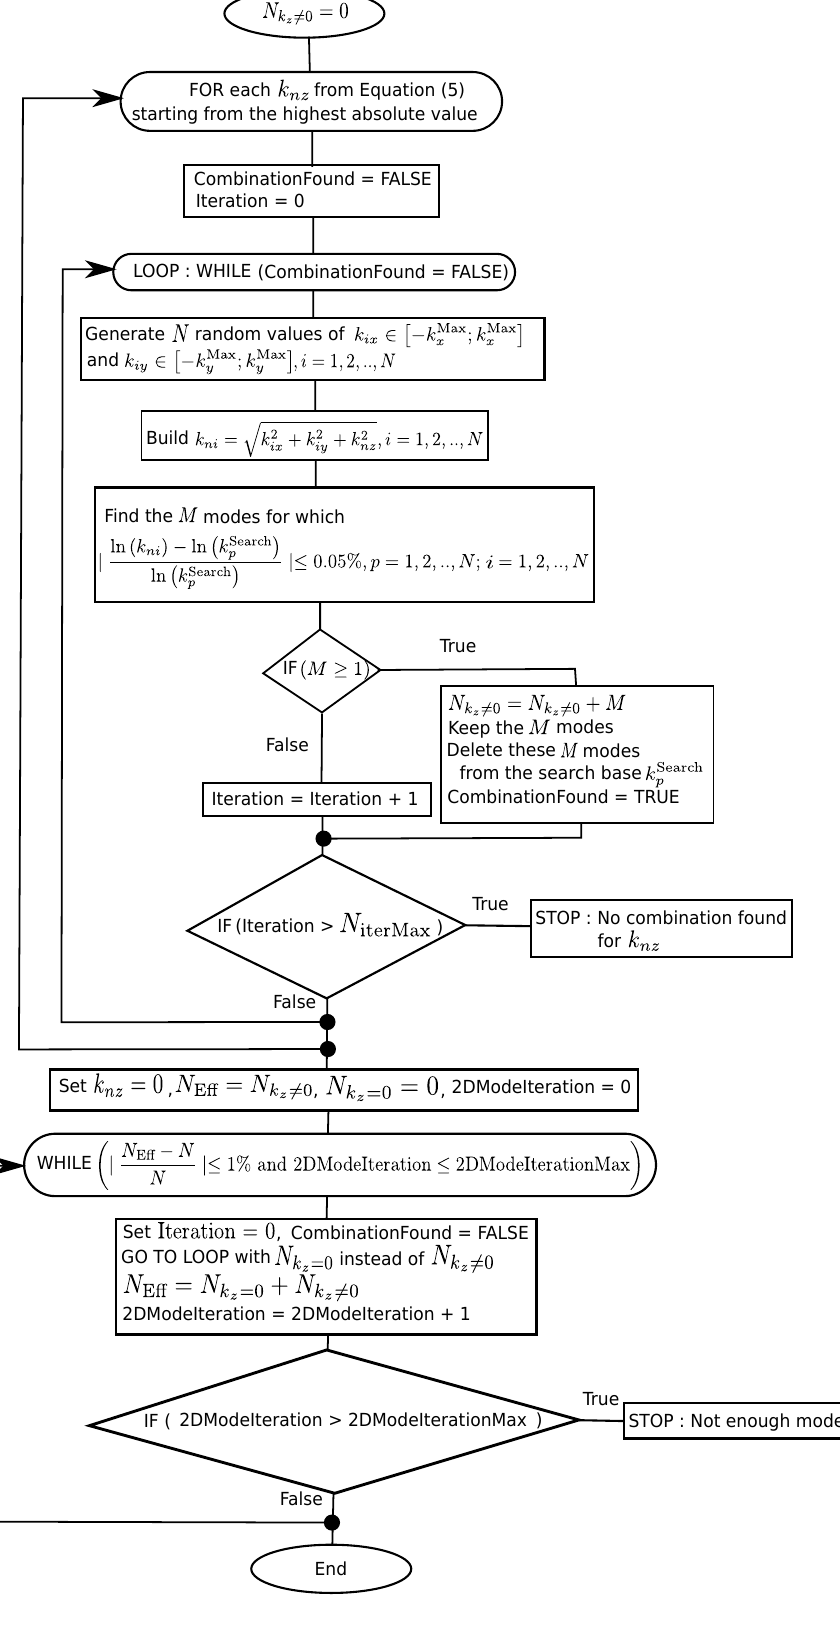
Figure 2. Flow chart for the RFM-P